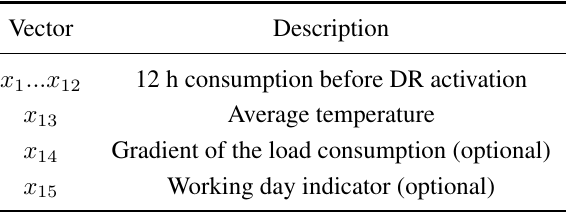
Table 1. Input vector for SOM